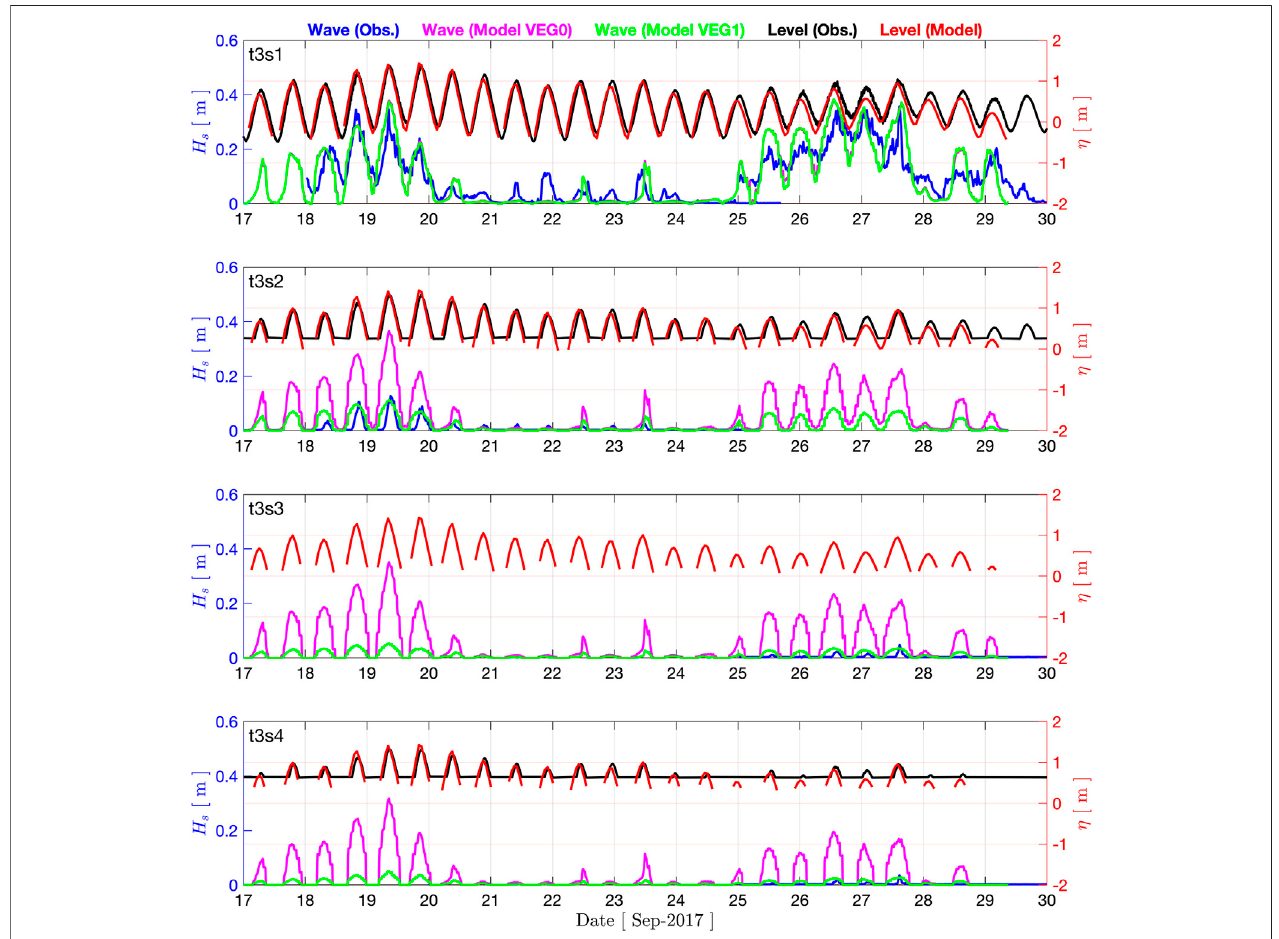
FIGURE 8 | Wave and storm surge Models ’ validation at the wave and water level gauges locations (transect BB) for signi fi cant wave height H s (observation: blue; WW3 without wave – vegetation interaction: magenta; and WW3 with wave – vegetation interaction: green) and water level elevation η (observation: black; and ADCIRC: